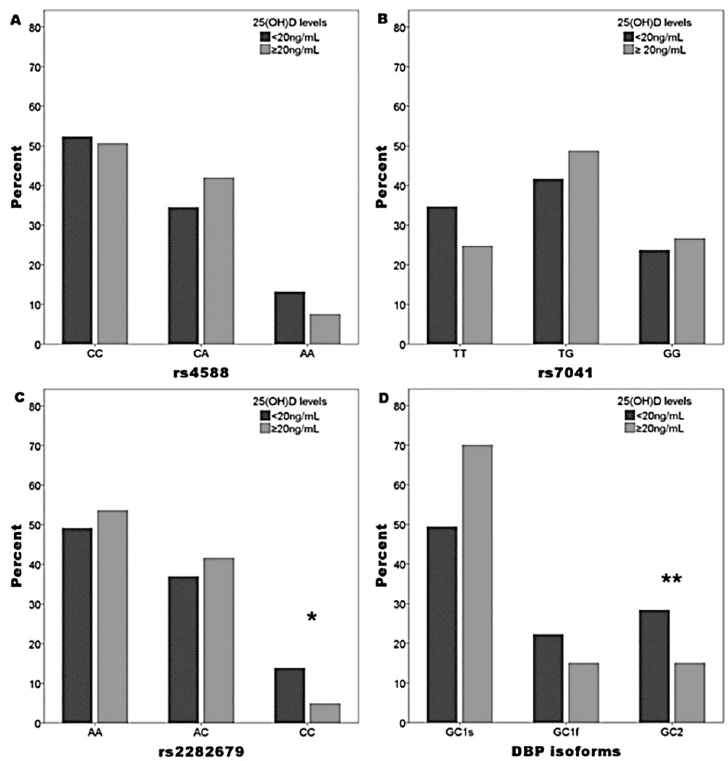
Fig 1. GC gene genotype and DBP isoform distribution according to 25(OH)D status. Data are expressed as percentages; p value by Pearson’s chi-square test. � p = 0.004 for SNP rs2282679; �� p = 0.016 for GC2 DBP isoform.